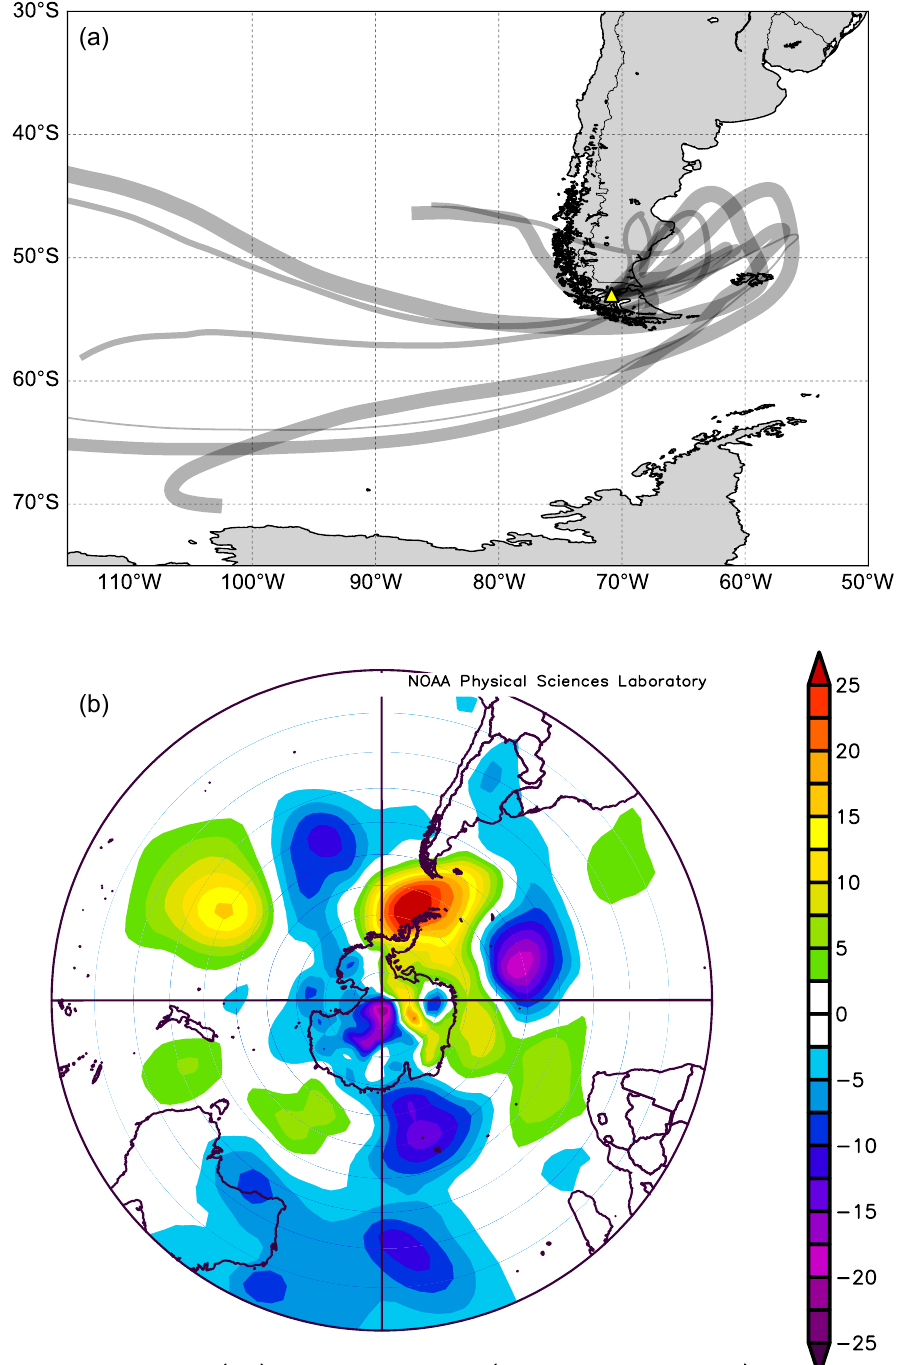
Figure 10. The synoptic condition for the historic extreme precipitation event occurred on 11–12 March 2012. ( a ) Modeled back-trajectories (n = 8) with their UTC time starting from 12:00 on 11 March 2012 to 06:00 on 13 March 2012. The trajectory line width is proportional to the 6 h precipitation amount associated with each trajectory. For reference, the thickest and thinnest paths on this graph represent 11.4 mm and 0.8 mm precipitation, respectively. Yellow triangle marks Punta Arenas. ( b ) Three-day SLP anomaly for this event relative to the 1981–2010 mean climatology in NCEP / NCAR reanalysis. The plot was generated on